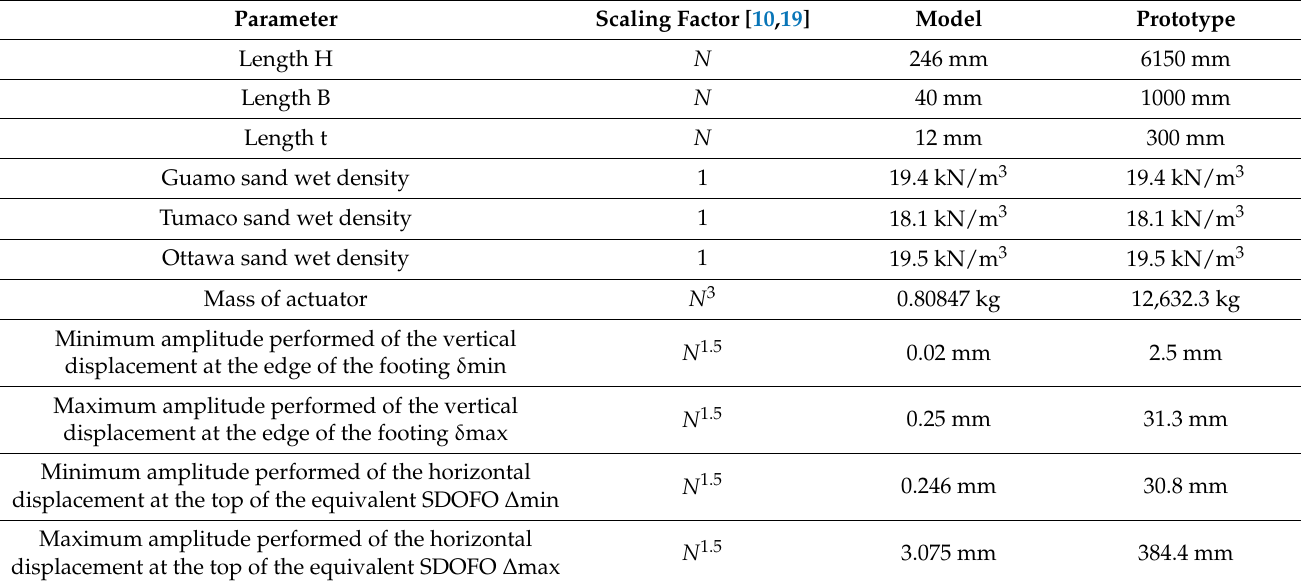
Table 1. Scaling laws and values from model to